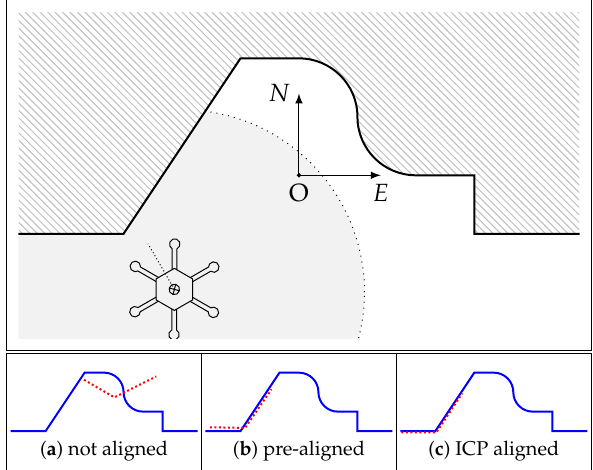
Figure 2. This schematic visualizes the different steps of the developed RTOB-SLAM method with a simple example. The top image shows the situation, where a multi-rotor vehicle faces a wall. The ‘forward’ direction is indicated by the dotted line. The shaded circular area represents the range of the laser scanner. The three sketches below illustrate the alignment process. The map (reference) is shown in blue, whereas the new laser scan that needs to be aligned is shown in red-dotted